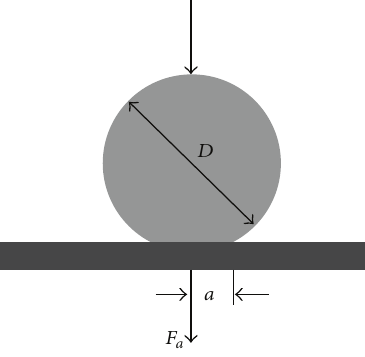
and wafer. Therefore, 𝑝 𝑟 can be considered as a constant. As a single particle is concerned, the applied force of pad on it 𝐹 𝑍